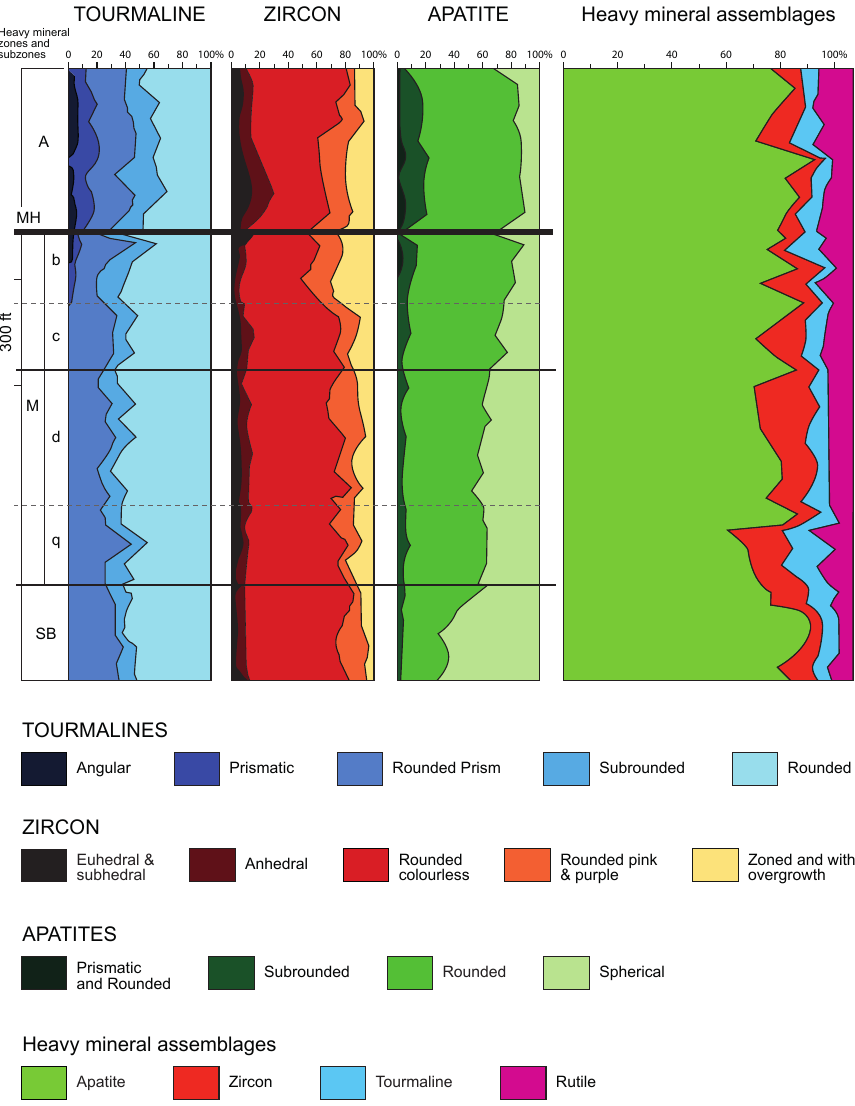
Figure 5. Stratigraphic subdivision of the Triassic Skagerrak Formation of well 22/24a-5Z (see Figure 1) using morphological variations of tourmaline, zircon, and apatite [34]. Note that the conventional heavy mineral data from the same interval show no systematic